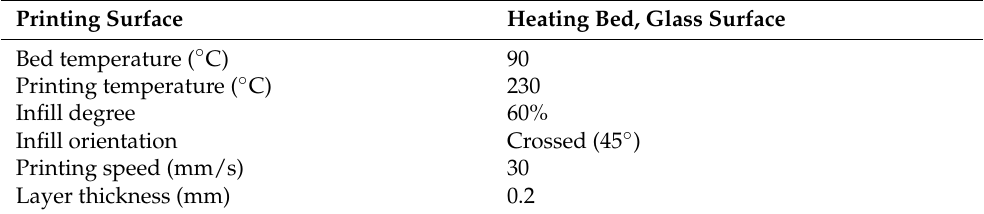
Table 1. PP 3D printing parameters.